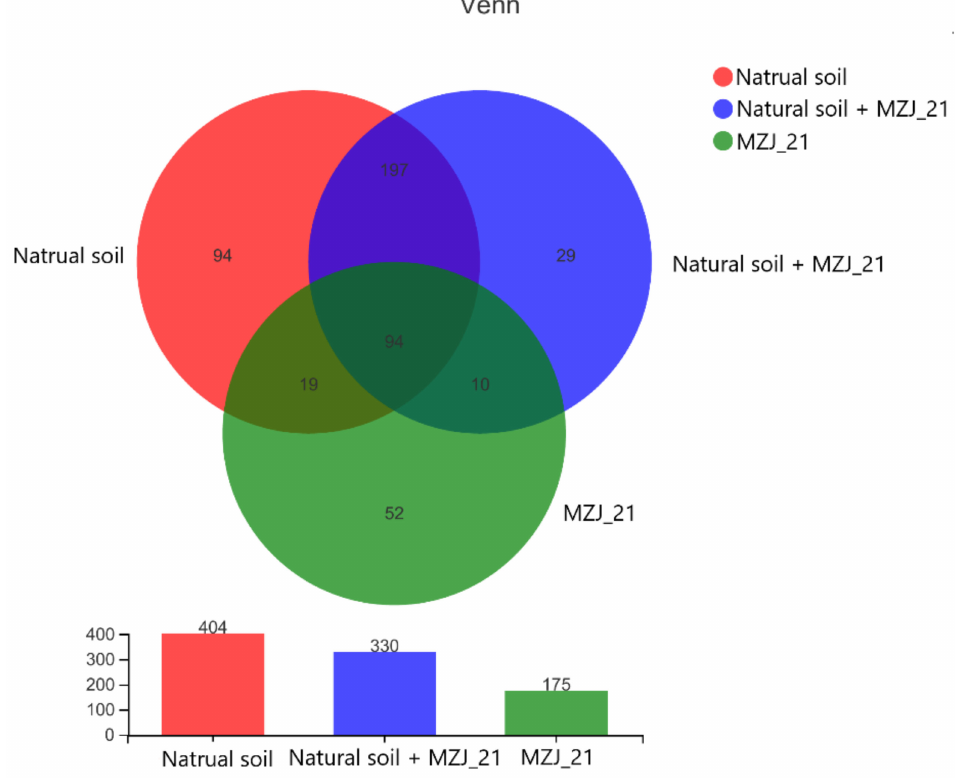
Figure 6. Venn diagram at genus level for different experimental